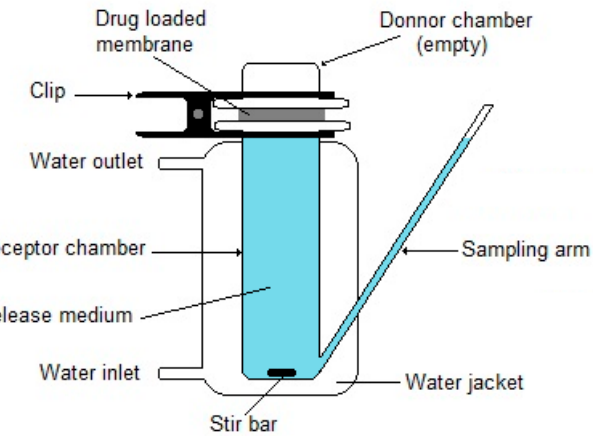
Figure 6. Schematic representation of a Franz diffusion cell, as employed in the study of drug release from a single face of drug-loaded membranes.